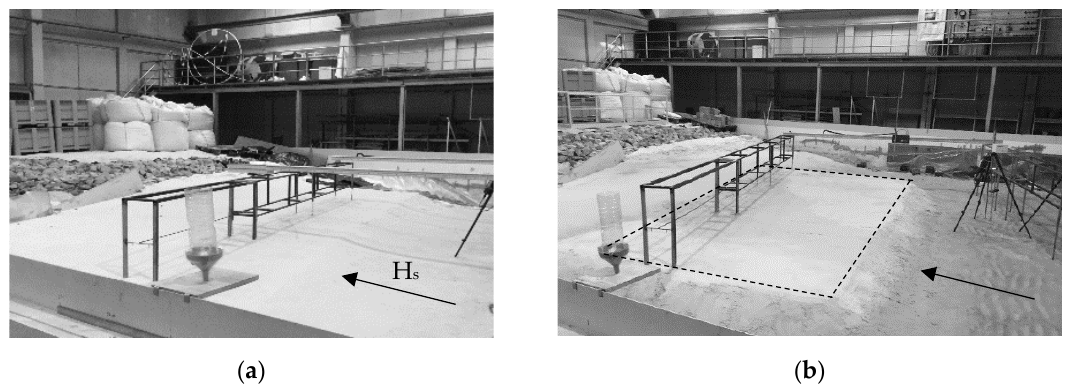
Figure 3. Initial beach configurations for both scenarios (the dashed lines represent the top limits of the nourishment emerged dimensions): ( a ) Initial beach before nourishment (Scenario A.1); ( b ) Initial nourished beach (Scenario A.2).